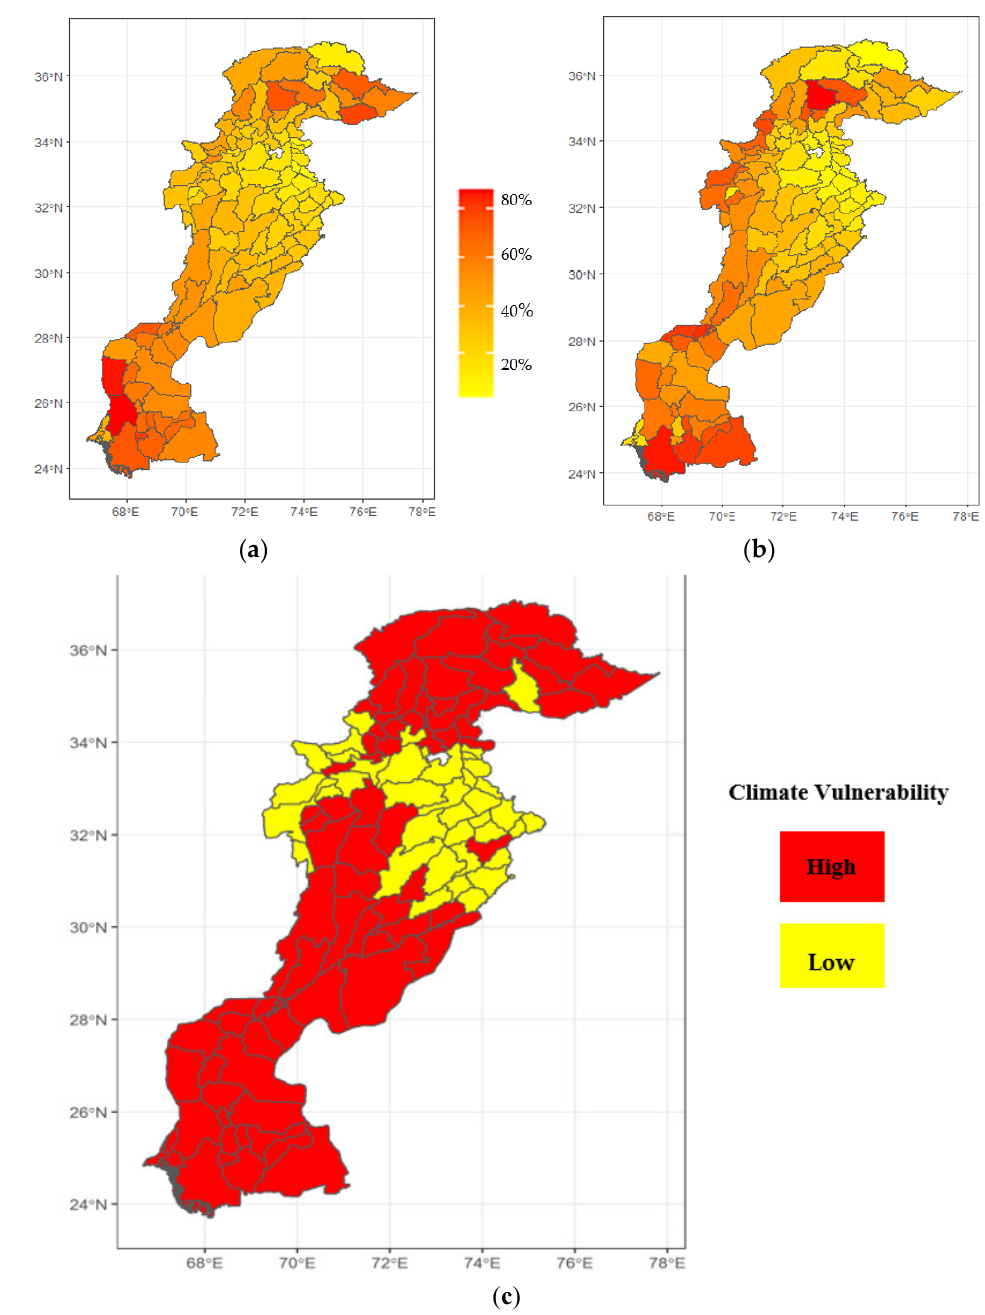
Figure 4. District-wise spatial distributions in Pakistan: ( a ) childhood stunting rate (%); ( b ) multi-dimensional poverty index (MPI) (%); ( c ) climate vulnerability based on MICS 2017-18 and ICA 2017.